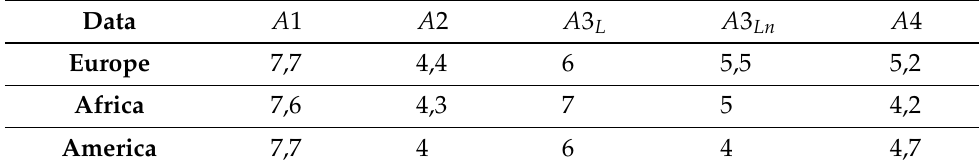
Table 2. User evaluations (/10) of different arrangements using various datasets.